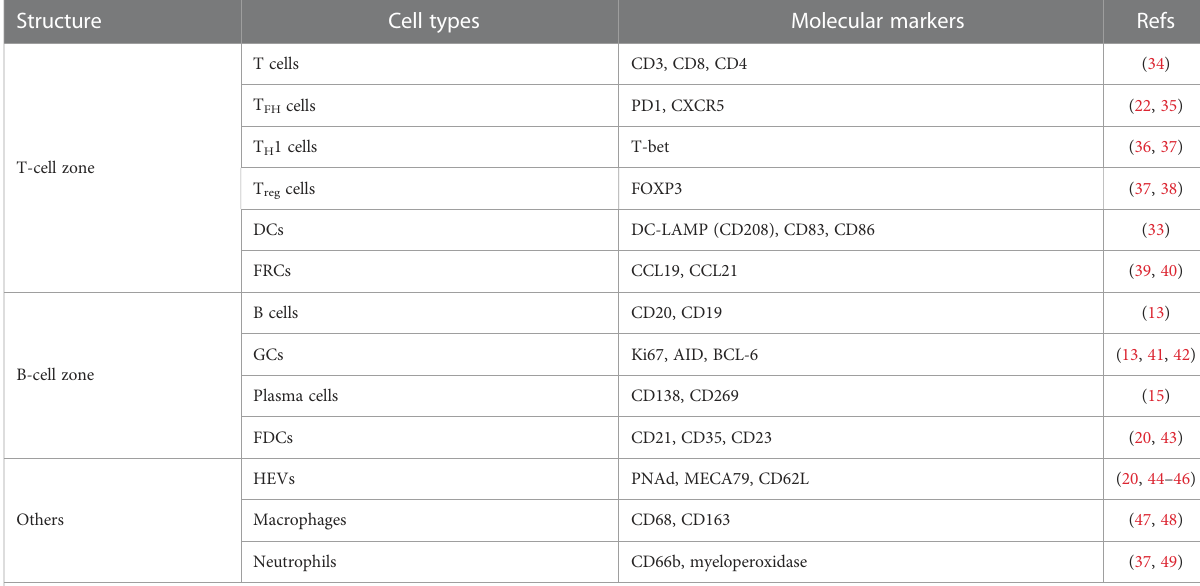
TABLE 1 Composition of TLSs and markers used for cancer detection.